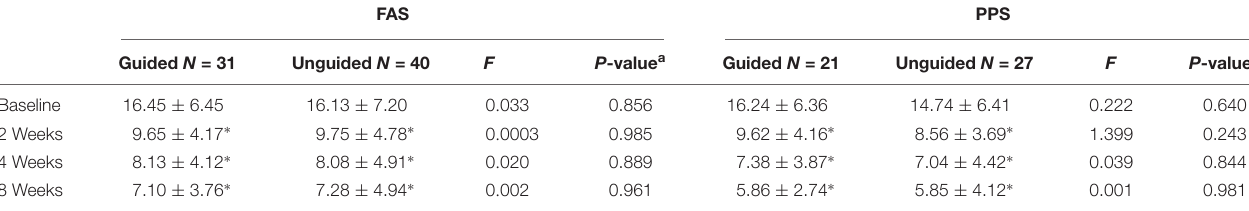
TABLE 6 | Comparison of the HAMA scores between Guided and Unguided group at each time point. FAS Guided N =